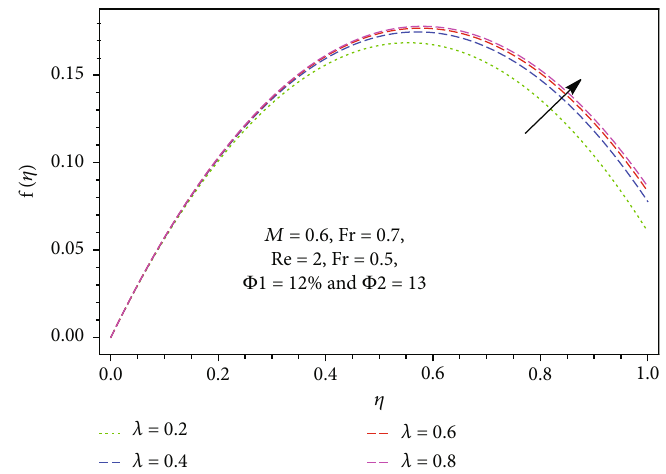
Figure 4: In fl uence of porosity parameter λ over momentum pro fi le f ð η Þ .